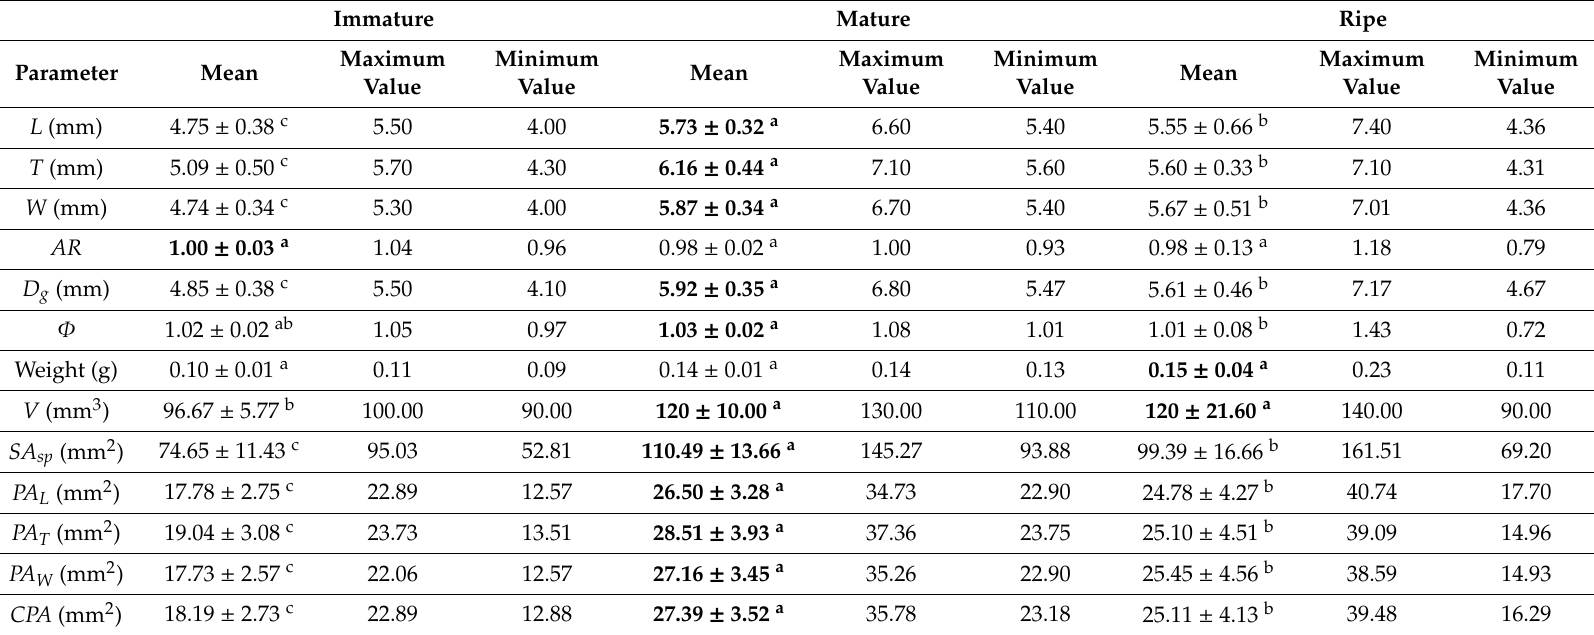
Table 1. Some physical properties of pepper berries at di ff erent maturity